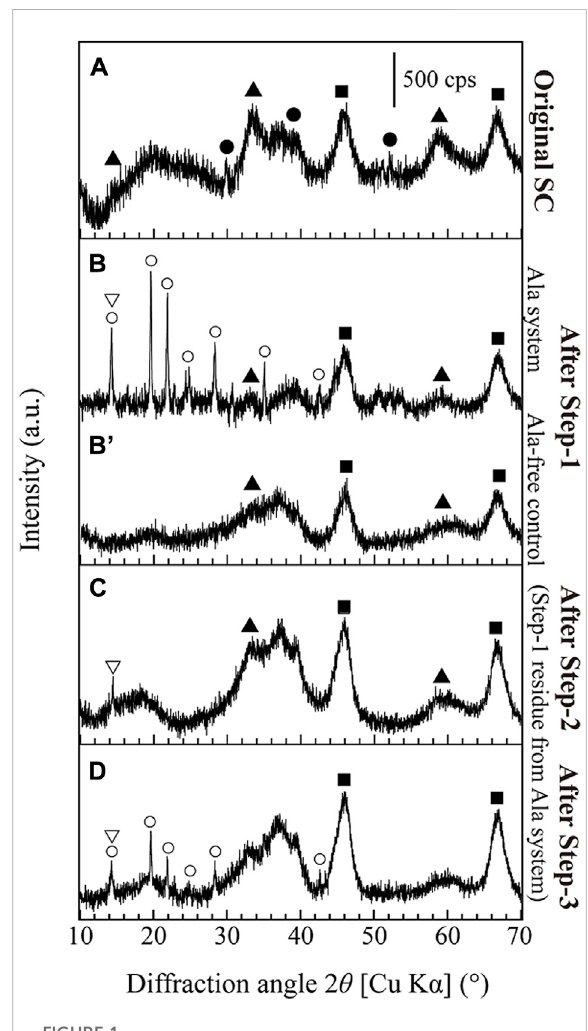
FIGURE 1 XRD patterns of; (A) the original spent catalyst, (B,B 9 ) the leaching residue after Step-1 (comparison of with or without Ala, respectively), (C) the leaching residue after Step-2 and (D) the leaching residue after Step-3. Symbols: ▲ (MoS 2 ; JCPDS No. 37-1492), C (Co 3 S 4 ; JCPDS No. 42-1448), ■ (Al 2 O 3 ; JCPDS